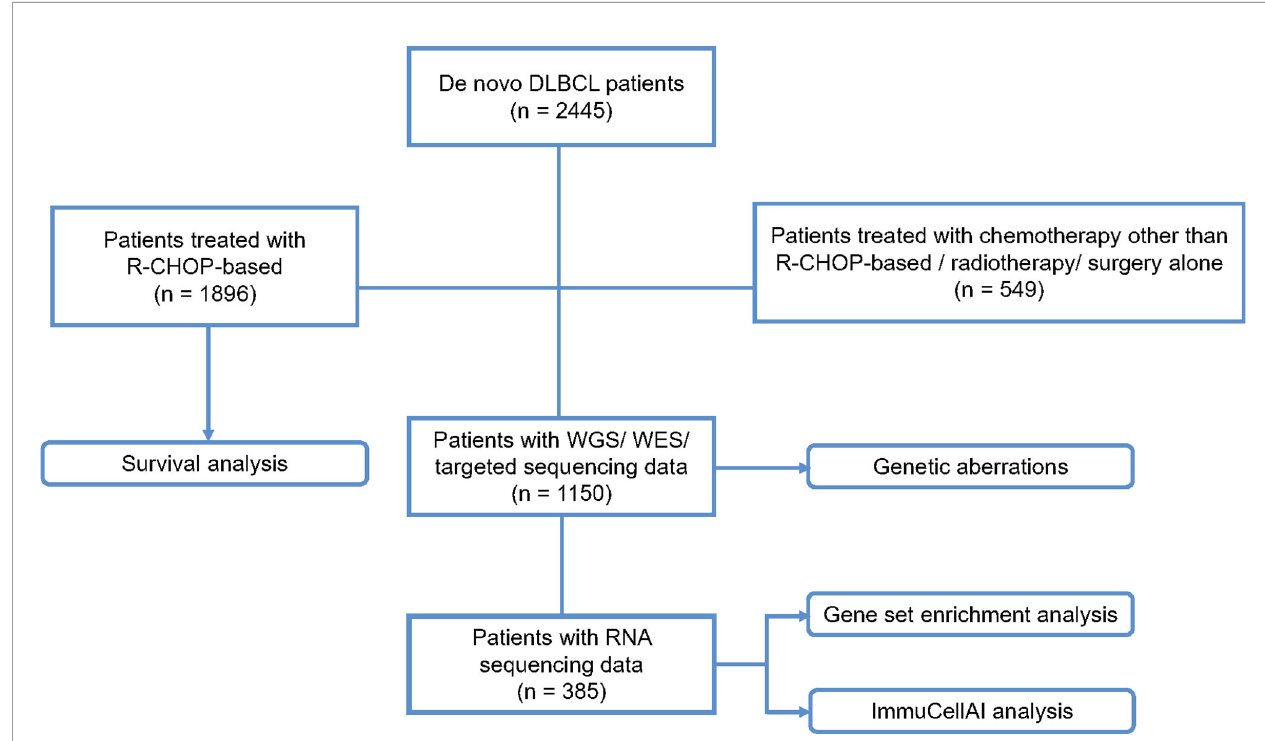
FIGURE 1 | Flow chart of the patient selection and methods. DLBCL, diffuse large B-cell lymphoma; R-CHOP, rituximab, cyclophosphamide, doxorubicin, vincristine and prednisone; WGS, whole genome sequencing; WES, whole exome